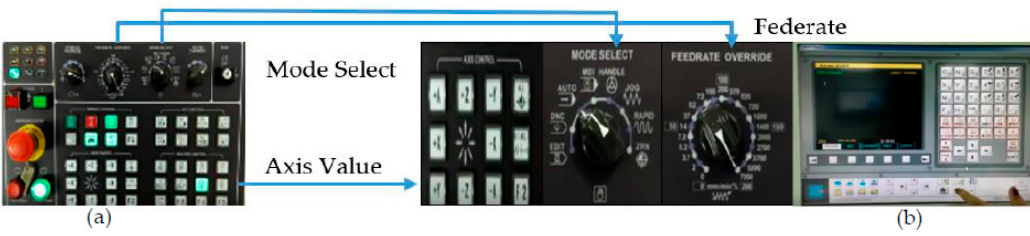
Figure 7. ( a ) Switches of computer-numerically controlled (CNC) milling control; ( b ) Display mode.